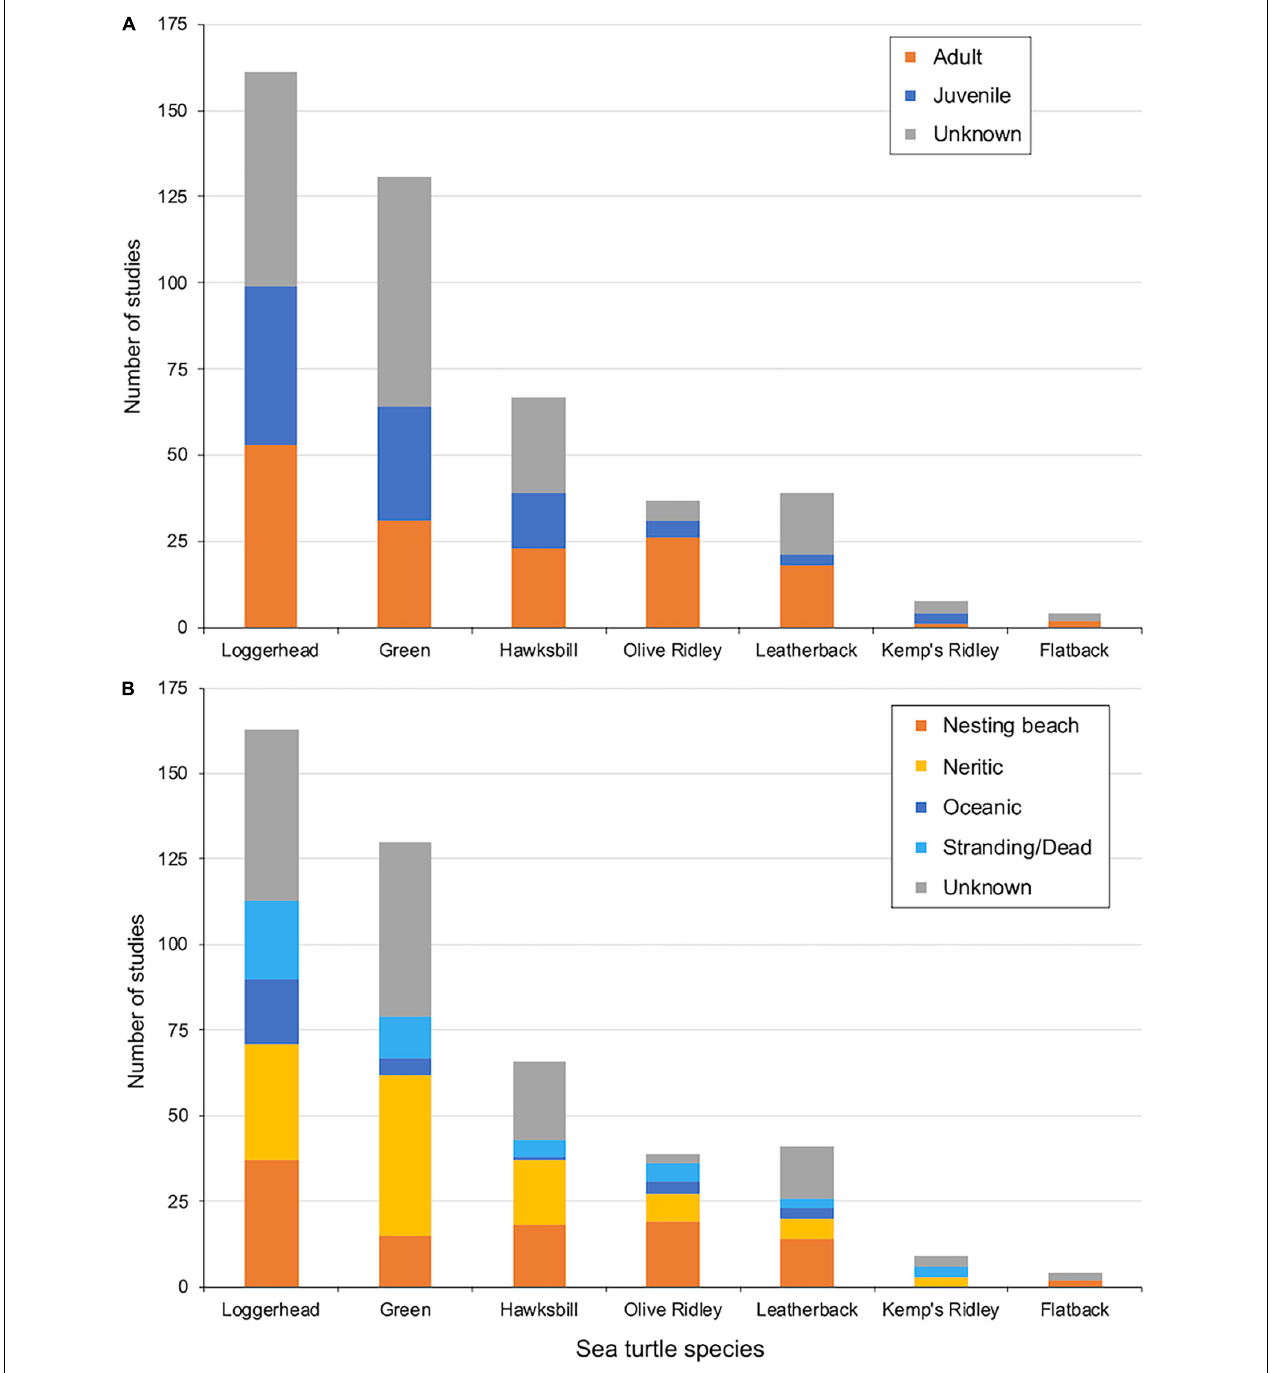
FIGURE 5 | (A) Number of epibiont studies separated by turtle species and life stage (either adult, juvenile or unknown). (B) Number of epibiont studies separated by turtle species and habitat type (nesting beach, neritic, oceanic, stranding/dead animals, or unknown).